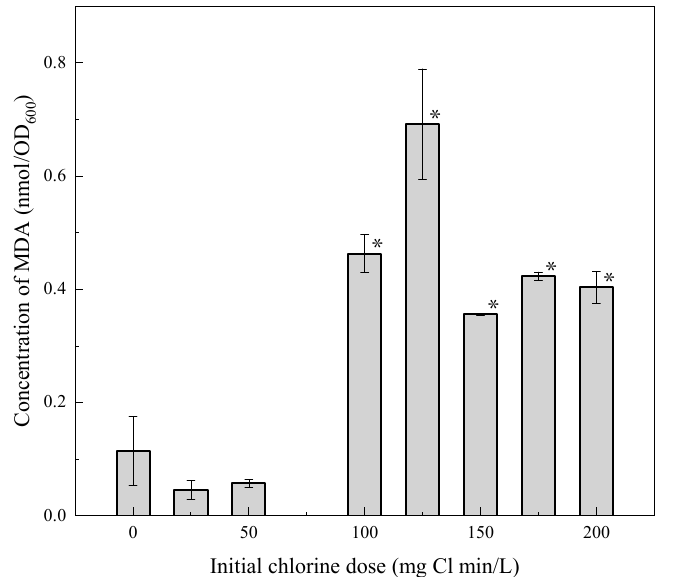
Figure 2. The concentrations of MDA in the bacterial suspension after chlorination. The error lines represent the standard deviation of 3 replicate experiments; the ‘*’ indicates a significant difference between the experimental and control groups.